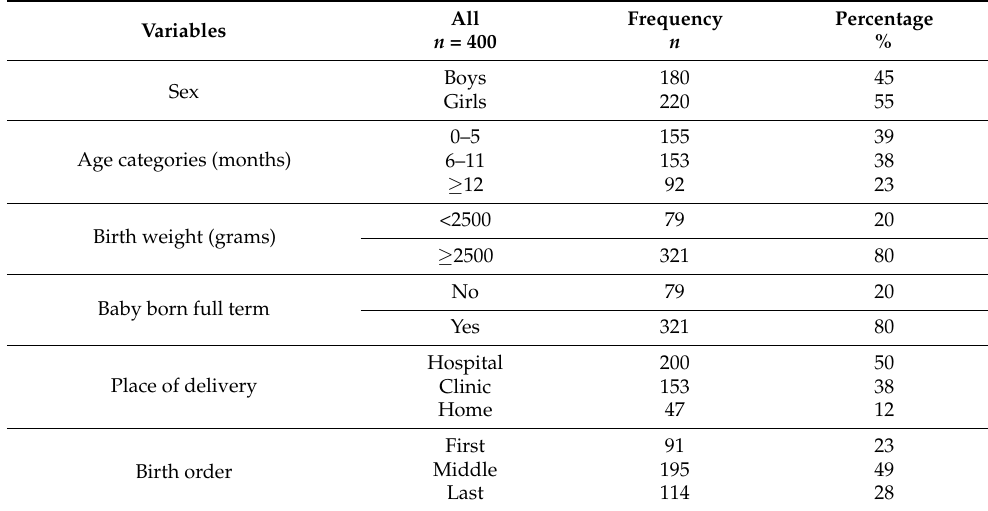
Table 1. Characteristics of children.